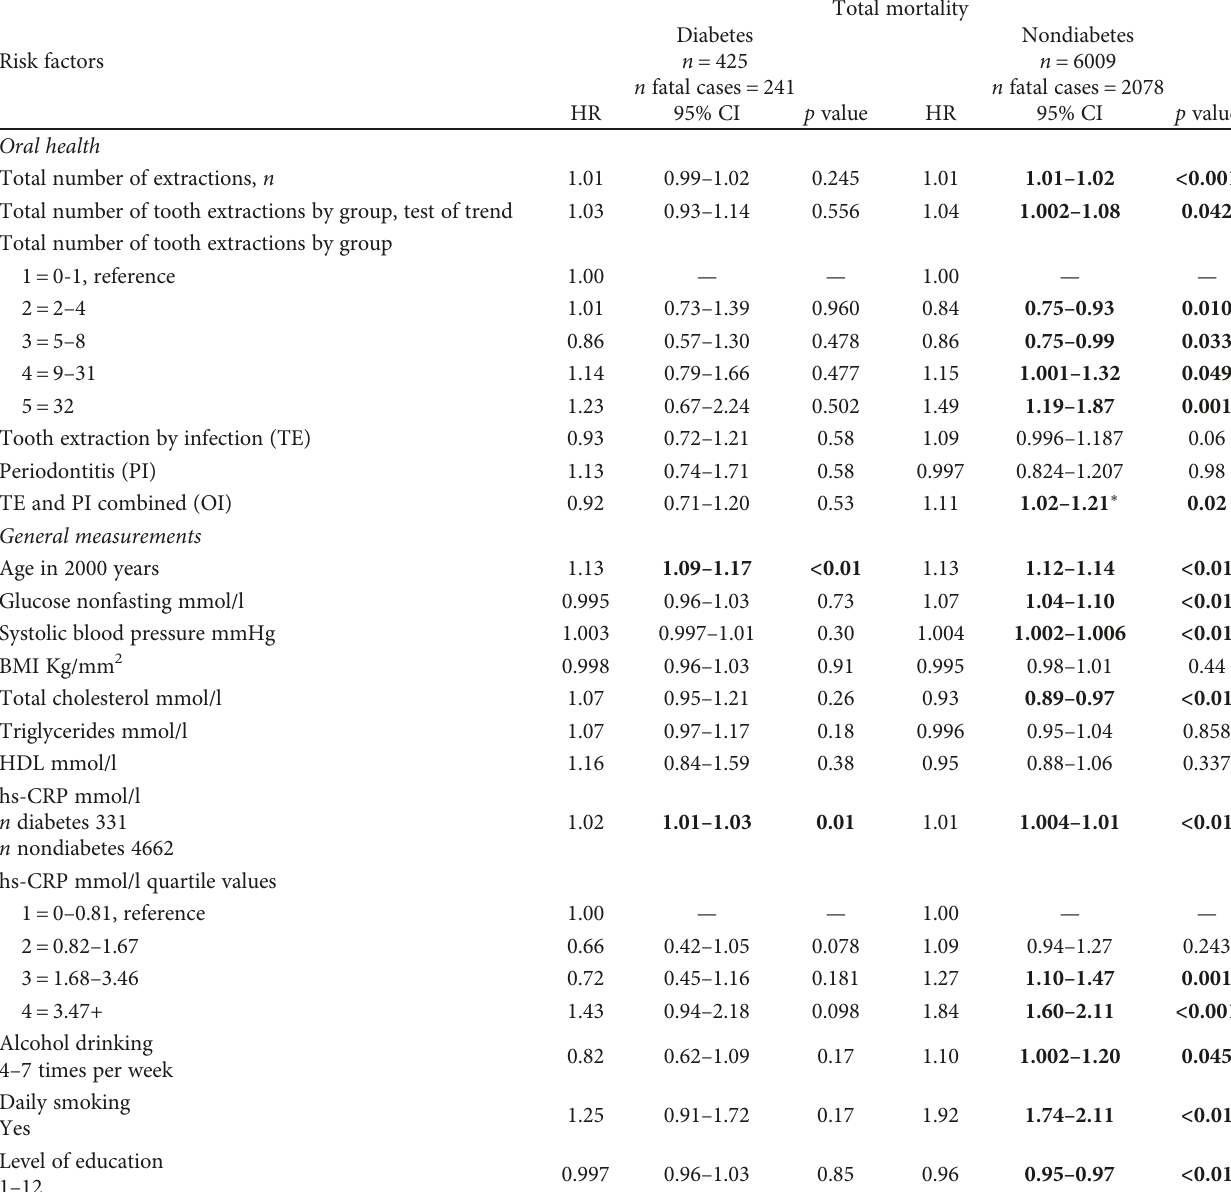
Table 2: Age-adjusted univariate Cox analyses for total mortality — individuals with or without diabetes. A 12 1/2-year follow-up of the Oslo II study of